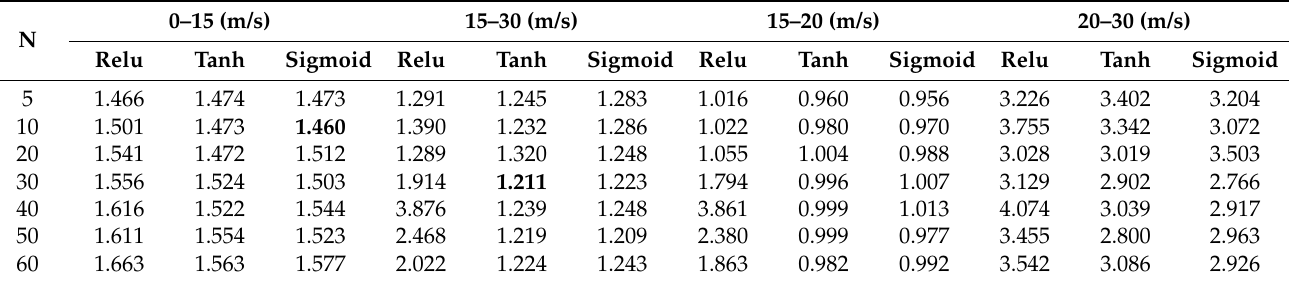
Table 5. RMSEs of the ANN models.